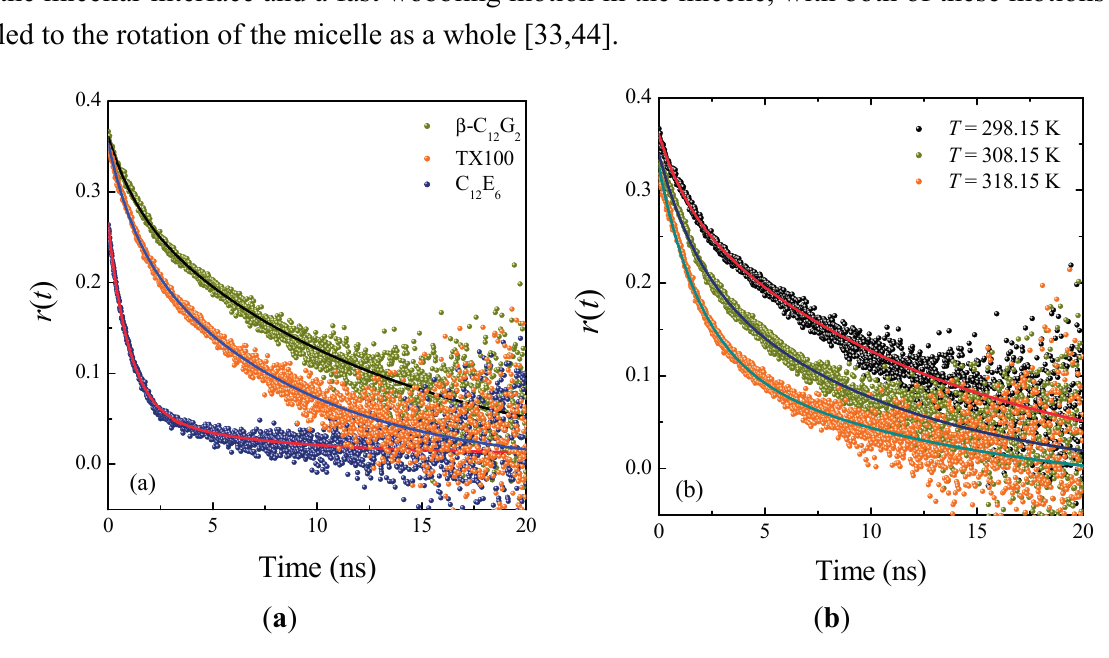
Figure 7. Time-resolved fluorescence anisotropy decays of C6 in: ( a ) micellar media of β -C 12 G 2 , TX100 and C 12 E 6 at 25 °C; and ( b ) micellar media of β -C 12 G 2 at different temperatures. The solid lines through the data points are the best fit to Equation